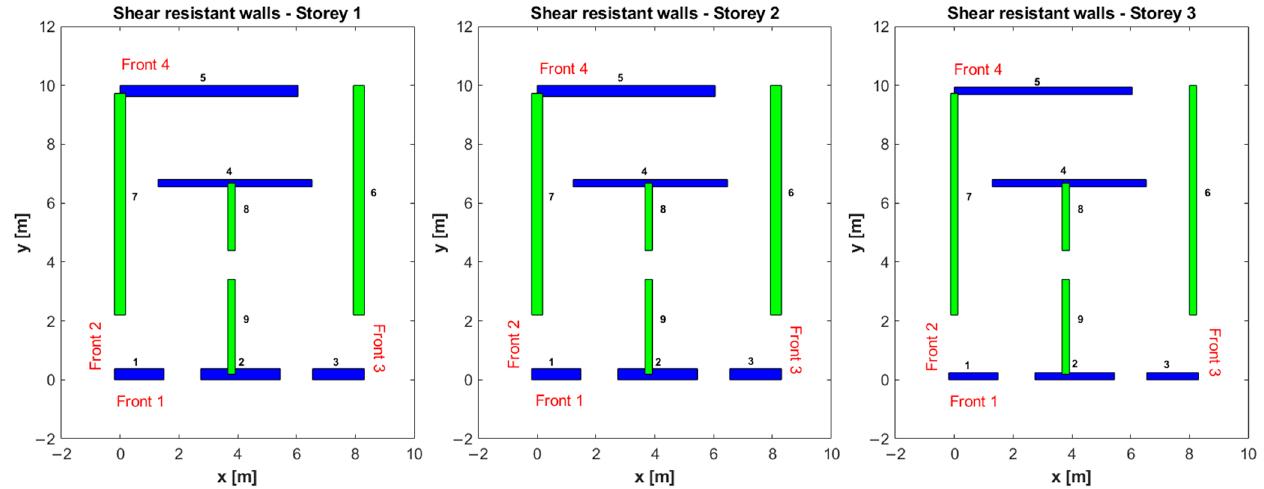
Figure 2. Layout of the shear resistant walls of the benchmark masonry building (wall thicknesses refer to Case B).